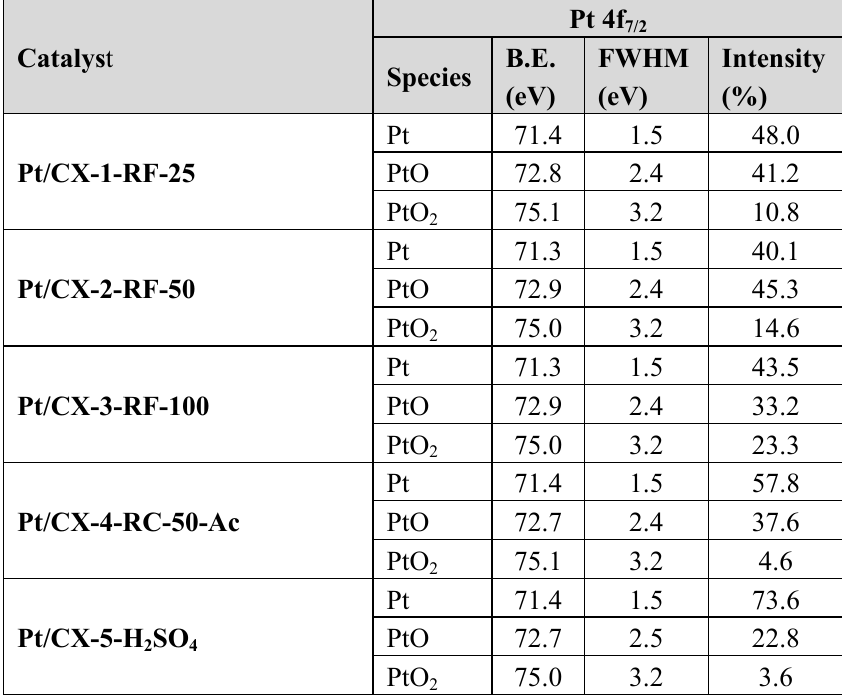
Table 4. Deconvolution of XPS Pt 4f